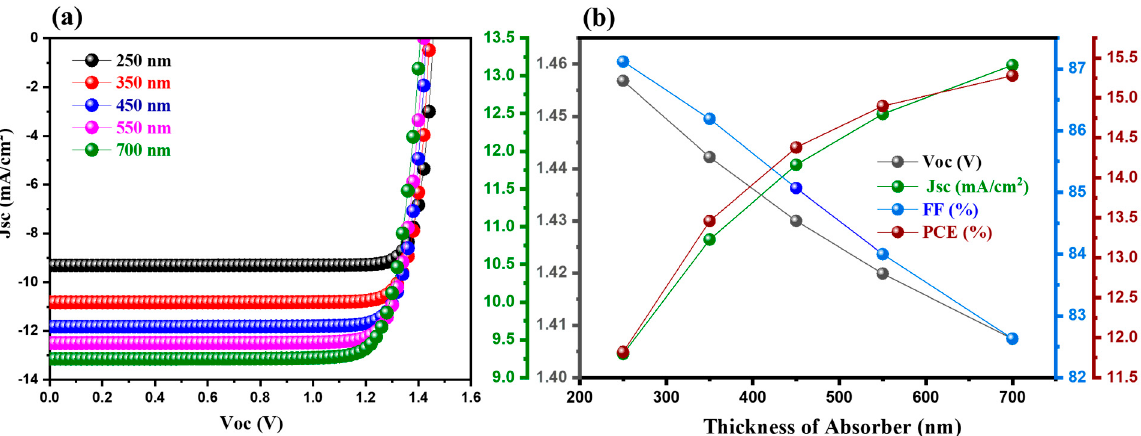
Figure Figure 3. J–V responses ( a ) and photovoltaic parameters ( b ) of the FTO/TiO 2 (150